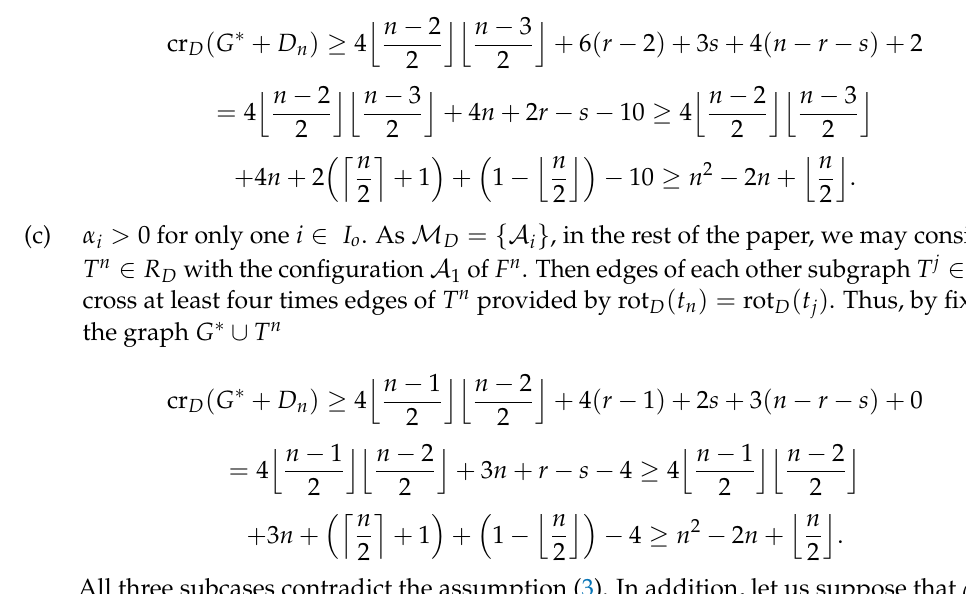
Figure 7a–c. Let us consider two subgraphs T n − 1 , T n ∈ R D such that F n − 1 , F n have different configurations from {A i , A j } , where i , j are associated